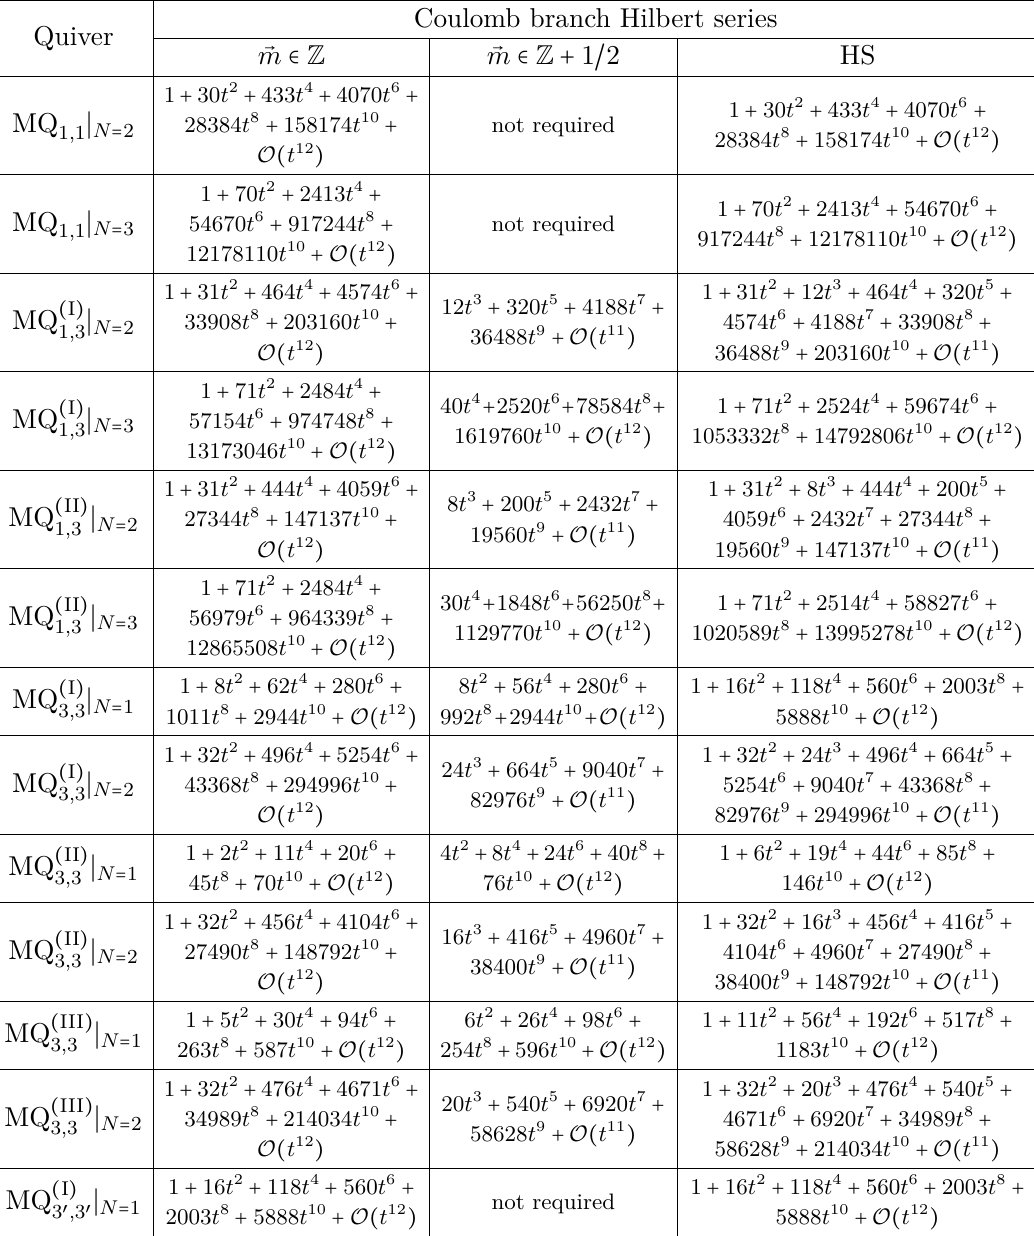
Table 10. The computation of Coulomb branch Hilbert series of orthosymplectic quivers given in main sections for small values of N . The full Hilbert series is given by summing over the integer and half-integer sublattices of the magnetic